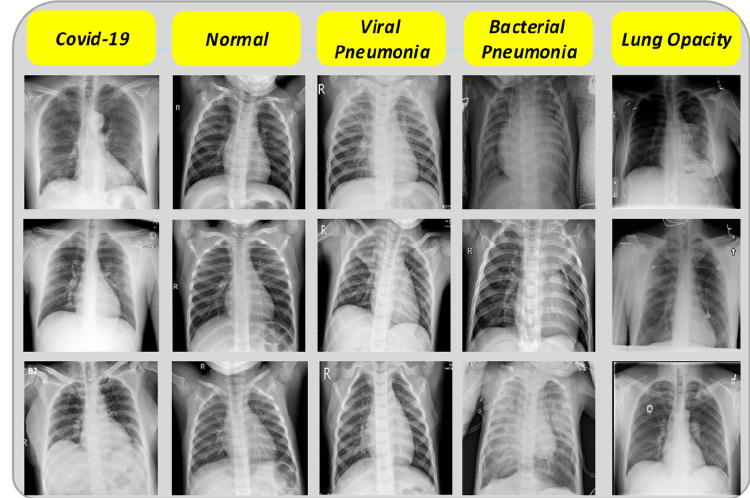
Figure 1. Sample X ‐ ray images. Figure 1. Sample X-ray images. Electronics 2022 , 11 , x FOR PEER REVIEW